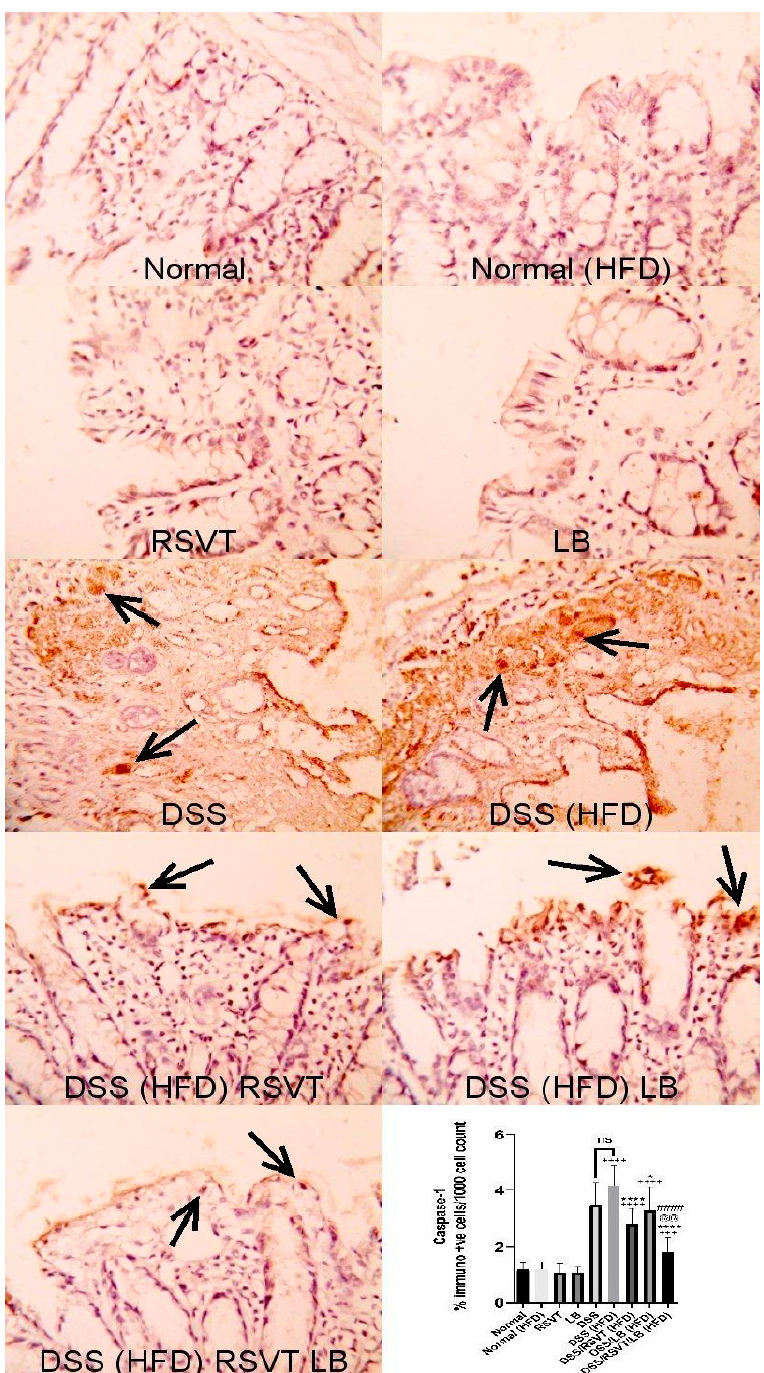
Figure 4. Photomicrographs of colon specimens showing caspase-1 immunoexpression. Normal, Normal (HFD), RSVT, and LB groups display normal caspase-1 immunoexpression. The DSS and DSS (HFD) groups display increased immunoexpression (open arrows). DSS/RSVT (HFD), DSS/LB (HFD) and DSS/RSVT/LB (HFD) rat groups showing a significant decrease in caspase-1immunoexpressiom compared with DSS/HFD. IHC, × 400. +++, p < 0.001 vs. Normal (HFD); ++++, p < 0.0001 vs. Normal (HFD); *, p < 0.05 vs. DSS (HFD); ****, p < 0.0001 vs. DSS (HFD); ####, p < 0.0001 vs. DSS/LB (HFD); @@, p < 0.01 vs. DSS/RSVT (HFD); ns,